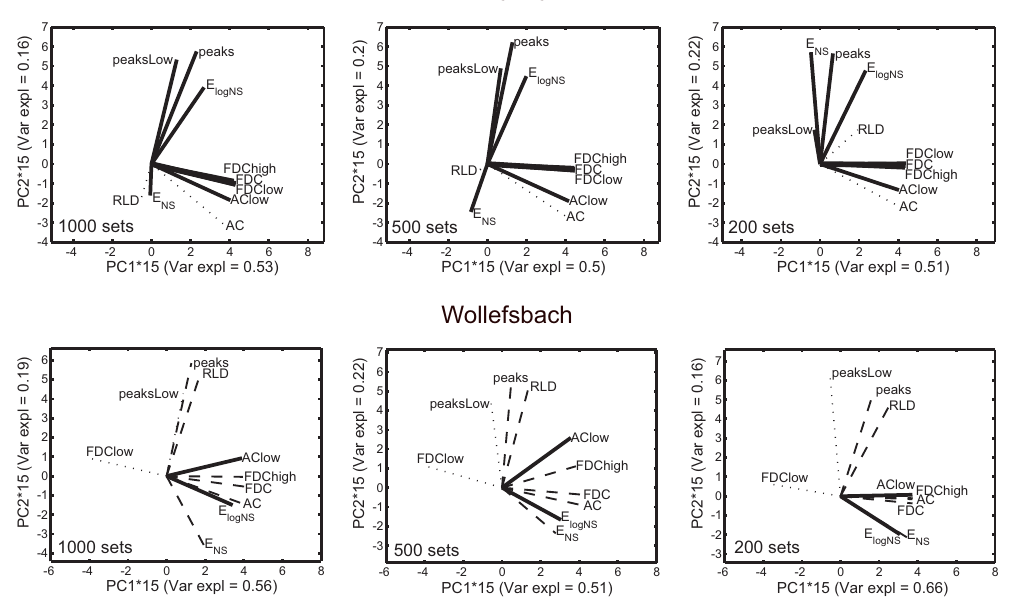
Fig. 11. Result PCA for M8 in Maimai (top) and Wollefsbach (bottom) for different number of parameter sets: 200(left)/500(middle)/1000(right). The difference between the diagrams with 1000 and 500 parameter sets is smaller than the difference between the diagrams with 500 and 200 parameter sets. The principal components are dimensionless. Table 7. Summary of differences between the PCA graphs for the calibration and the independent test period for the Wollefsbach catchment (EC=evaluation criterion). The model structures are ordered by consistency in the calibration period. 1, 2 or 3 “EC changed” in the last column means the configuration of the PCA diagram of the calibration and validation are equal, but 1, 2 or 3 vectors have a different direction and/or length. “conf. changed” means that the relative direction of almost all vectors